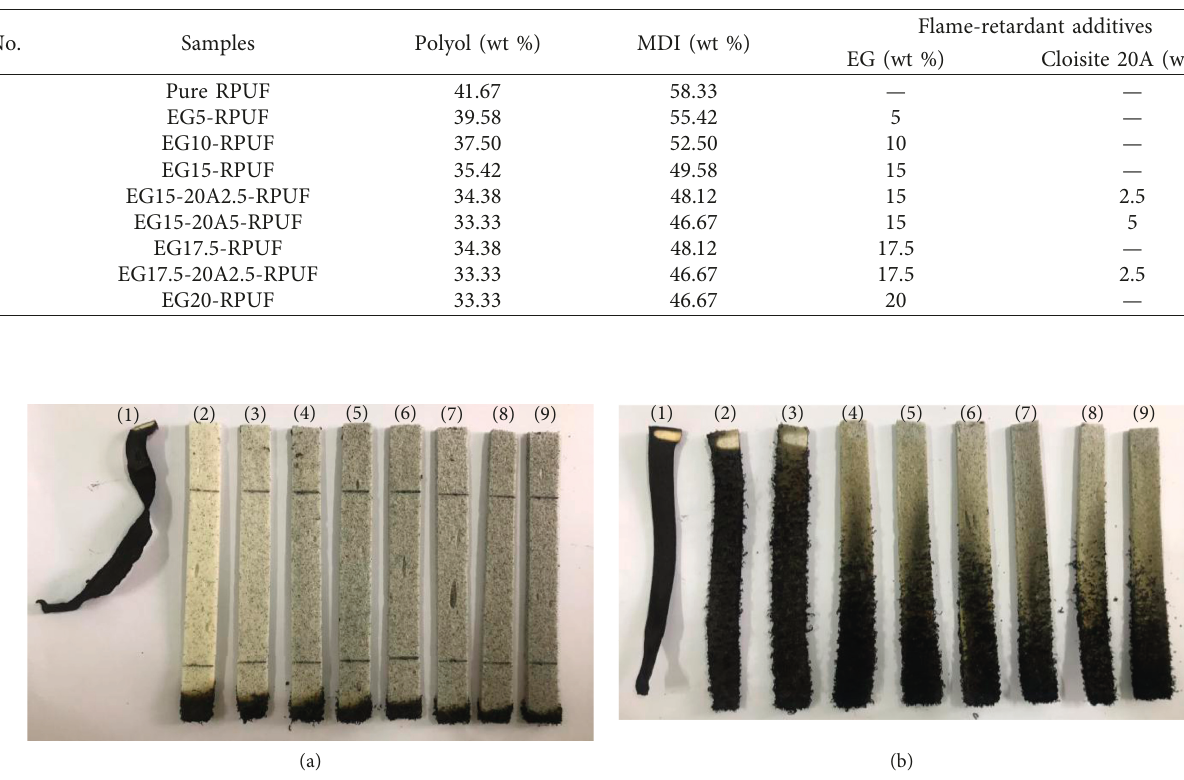
Table 1: Compositions of RPUF